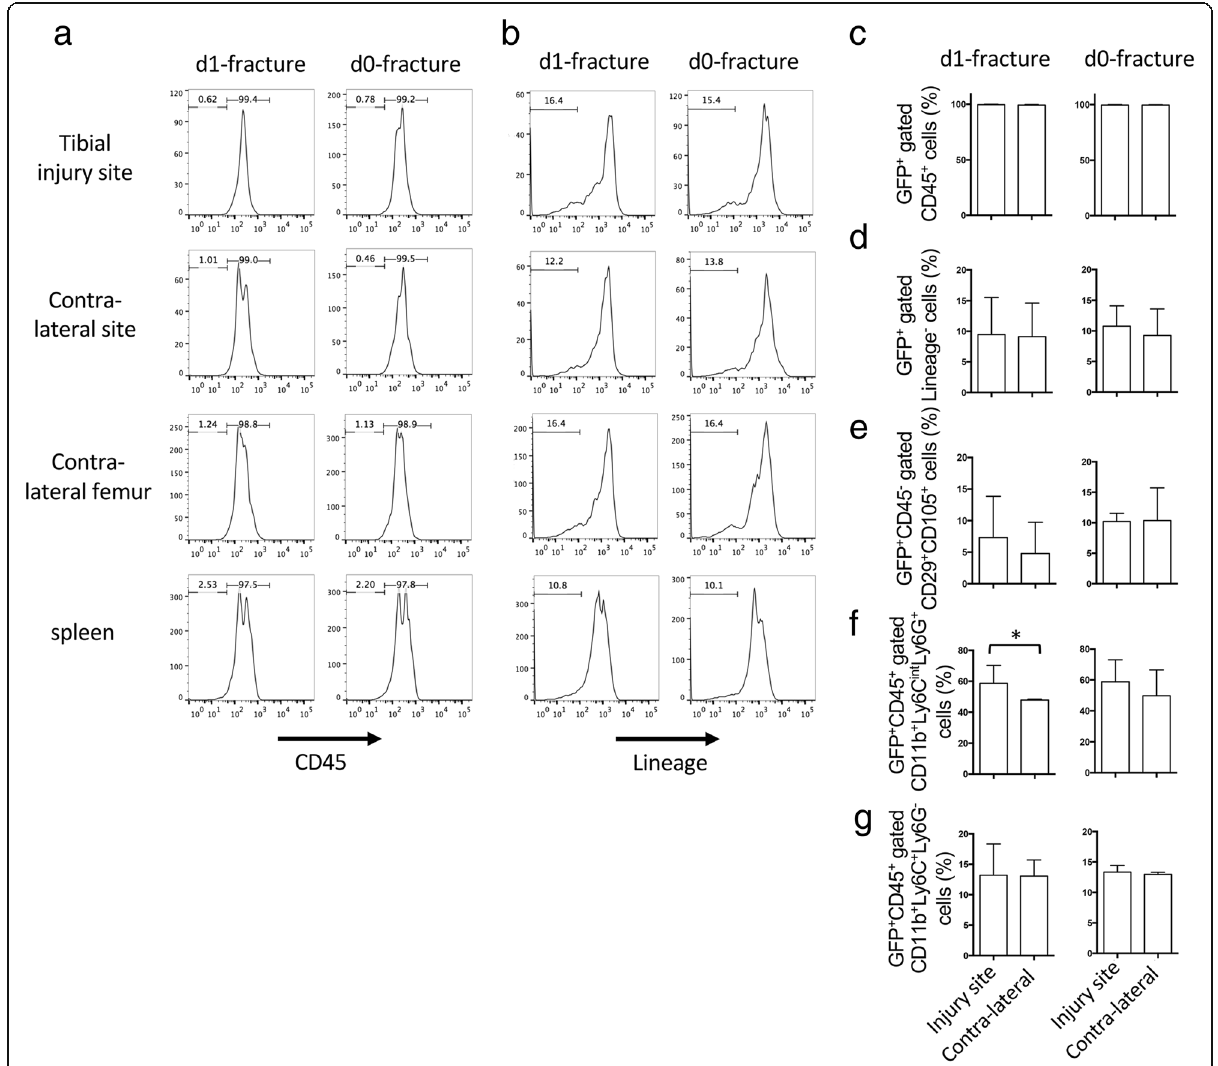
Fig. 5 Flow cytometry analysis demonstrates that the donor BM cells homing to the fracture site are mostly hematopoietic cells stem/progenitor cells and inflammatory cells. a BM cells from GFP transgenic mice were used as donor cells in d1- and d0-fracture models. One day later, cells were harvested from the fractured section of the tibia, corresponding contralateral tibia section, BM from non-fracture side femur, and spleen ( n =4). Flow cytometry analysis indicated that almost all the GFP + cells found in these tissues expressed CD45 (representative data). b The fraction of Lin − cells in GFP + donor cells is indicated (representative data). c – g Comparison of cell fractions found in the sections of fractured vs non- fractured tibia is shown. CD45 + cells ( c ) and Lin − cells ( d ) within the donor cells, CD29 + CD105 + cells within non-hematopoietic donor cells ( e ), Ly6C intermediate (int) Ly6G + cells ( f ), and Ly6C + Ly6G - cells ( g ) within CD11b + donor cells were analyzed. Ly6C int Ly6G + cells migrated to the fracture significantly higher than the non-fractured tibia ( n = 4 in each group, * p < 0.05 with Mann-Whitney